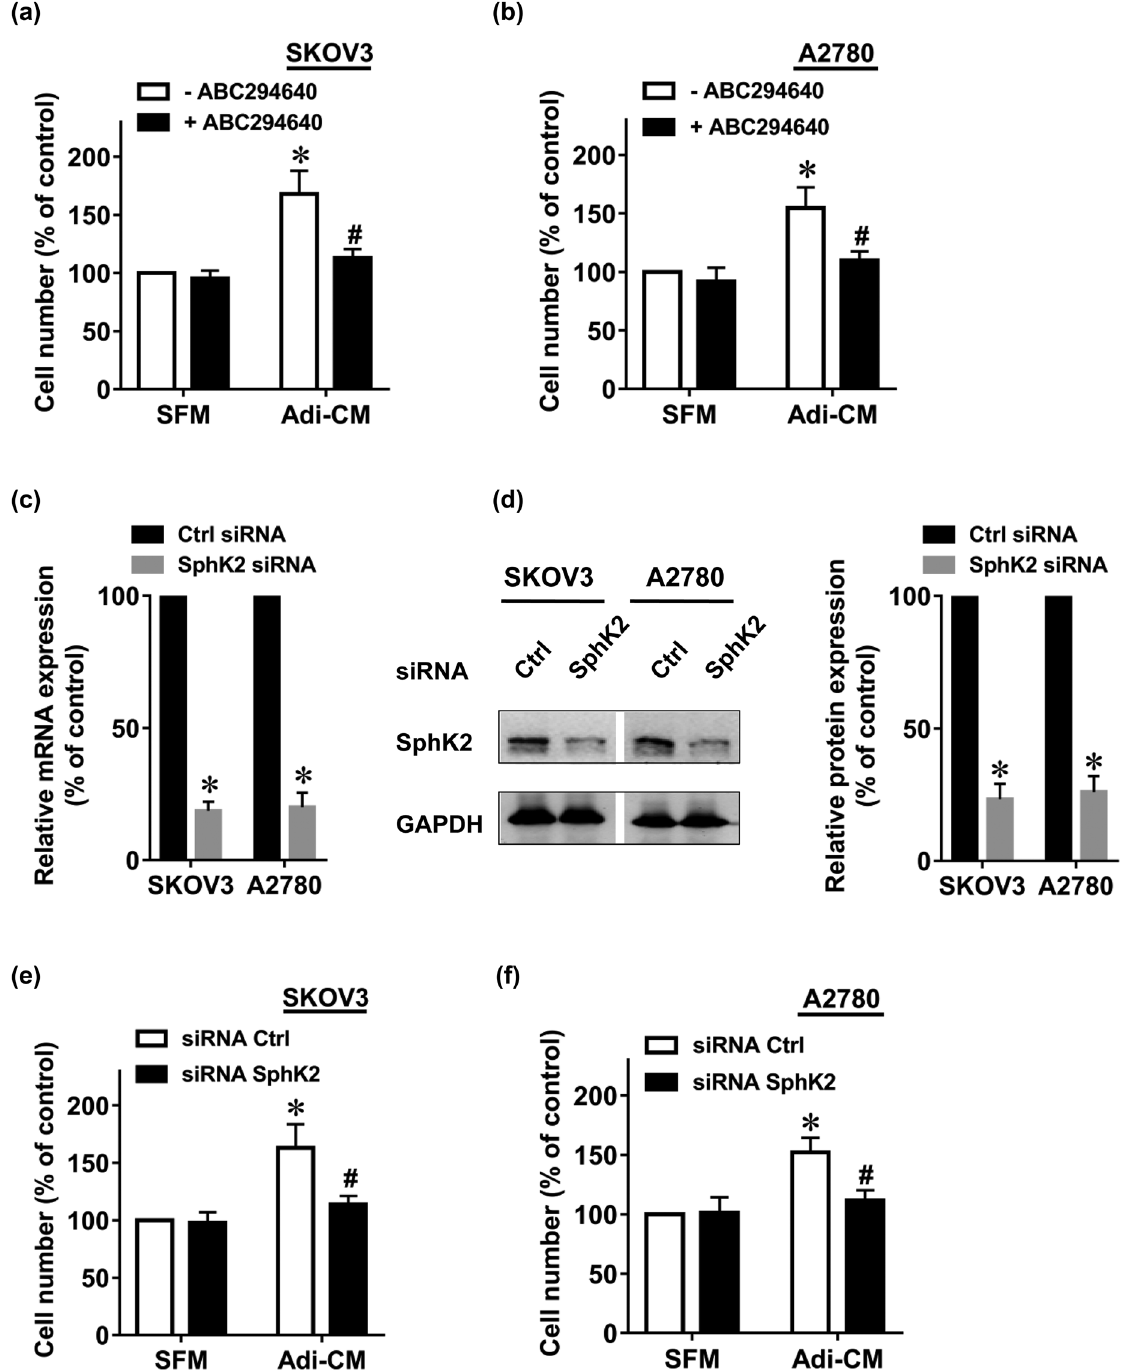
Figure 1: SphK2 inhibition suppresses the adipocyte - induced EOC cell growth. The human EOC cell lines ( a ) SKOV3 and ( b ) A2780 were serum - starved overnight and then cultured with SFM or Adi - CM in the presence or absence of ABC294640 ( 10 μ M ) for 48 h. Cell proliferation was measured by CCK - 8 assay. ( c ) Twenty - four hours after siRNA transfection, SphK2 mRNA levels were determined by RT - PCR. ( d ) Forty - eight hours after siRNA transfection, SphK2 protein levels were determined by using Western blot. Densitometric analysis of SphK2 ( normalized to GAPDH ) is shown on the right. ( e ) SKOV3 and ( f ) A2780 cells were transfected with the indicated siRNAs, followed by culture with SFM or Adi - CM for 48 h. Cell proliferation was measured by CCK - 8 assays. Molecular weight of SphK2 is 69 kDa, and molecular weight of GAPDH is 36 kDa. Data are mean ± SD. *, P < 0.05 vs control; #, P < 0.05 vs Adi - CM